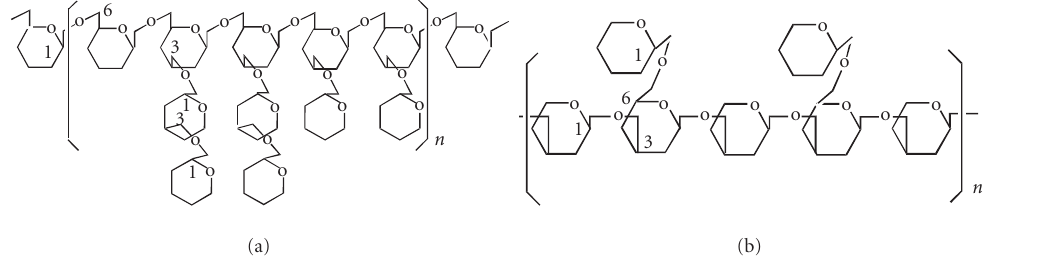
Figure 2. Repeating unit of immunomodulatory β -glucans (a) from Grifola frondosa (D-fraction, MW: 1000 kD) and (b) from L edodes (lentinan, MW: 500 kD).